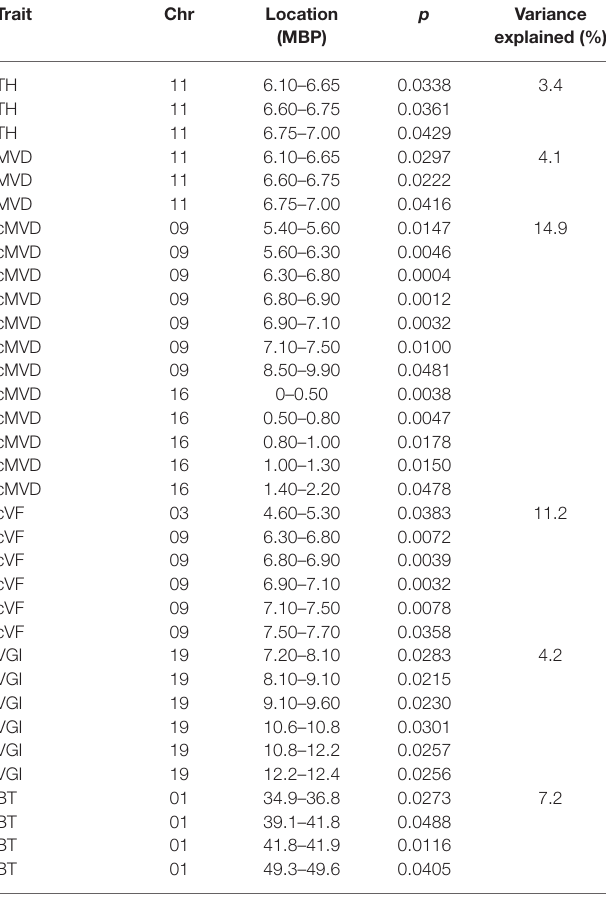
TABLE 4 | Locations of all genomic bins with significant correlations ( p < 0.05) with stem or wood anatomical traits